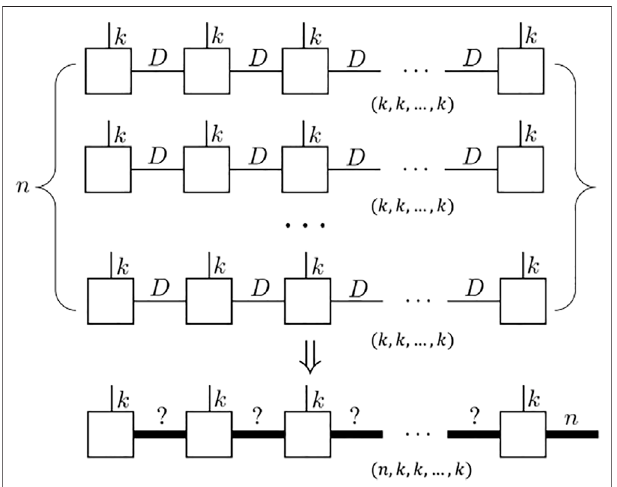
FIGURE3| SchematicsofstackoperationsforMPS:illustrationforthe n identicalMPSwithauxiliarybonddimension D whichends upwithanewMPS with same physics dimension. One of the sites should have an extra bond dimension n to ful fi ll the stack dimension requirement (here we set the last